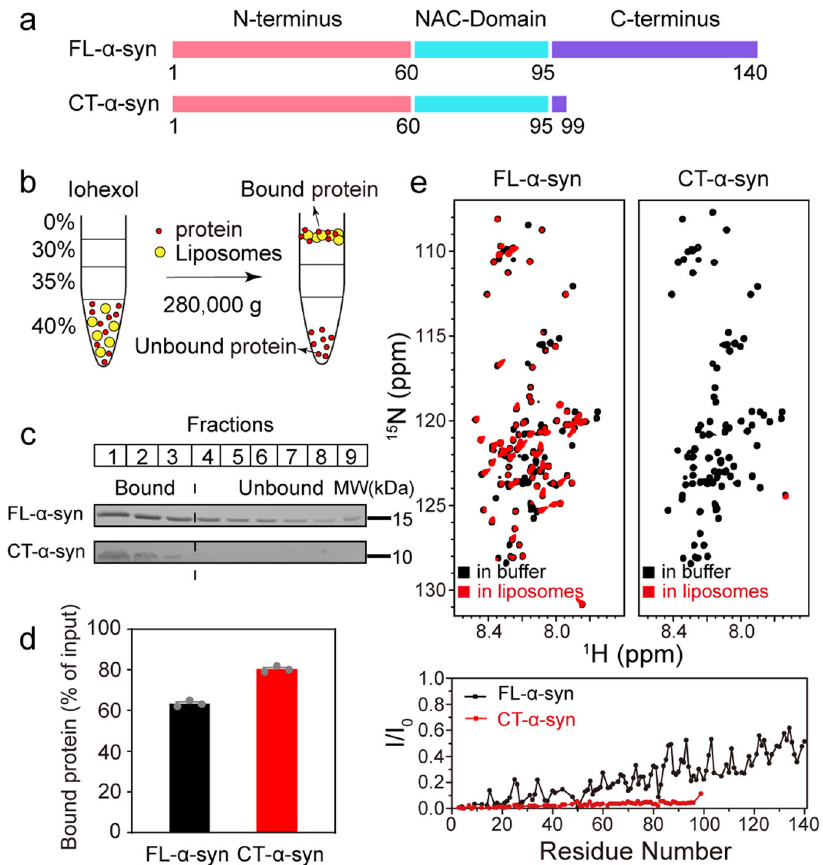
Fig. 1 Stronger interaction of CT- α -syn with membrane. a Primary structure schematic of FL- and CT- α -syn. b Cartoon of co fl otation assay. c SDS-PAGE of fractions post centrifugation using POPC/CL (7:3 mole ratio) liposomes. FL- and CT- α -syn were run on SDS-PAGE independently. d The proportion of lipid-bound protein from SDS-PAGE data. Uncertainties are the standard error of the mean from three independent trials. e Overlaid 1 H- 15 N HSQC spectra of 0.12 mM 15 N-enriched FL- and CT- α -syn in the absence (black) and presence (red) of 12 mM POPC/CL (7:3 mole ratio) liposomes and residue-resolved attenuation (I/I 0 ) of FL- (black circles) and CT- α -syn (red circles) upon adding liposomes. Values <1.0 indicate